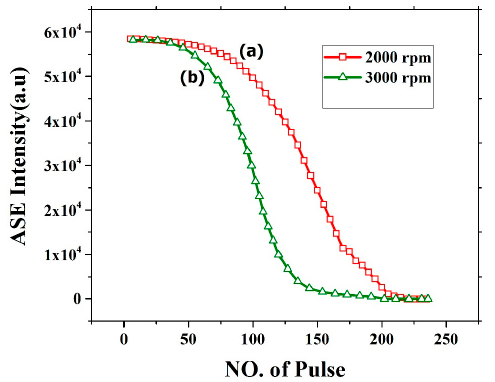
Figure 16. ASE stability of CO films with di ff erent thickness at di ff erent speed ( a ) 2000rpm and ( b ) 3000 rpm with 250 pulse and energy 2.5 mJ.